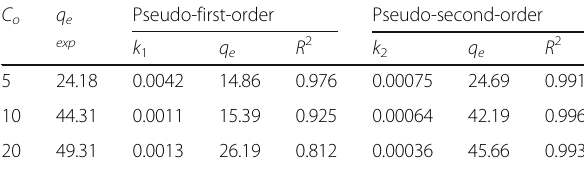
indicated the presence of GO in N6,6. The adsorption behavior of Cr (VI) onto N6,6/GO nanofibers was inves- tigated and the adsorption was found to be dependent on pH, adsorbent dosage, initial Cr (VI) concentration, and contact time. The maximum adsorption for Cr (VI) was at pH 2.0. The equilibrium between Cr (VI) and nanofibers was reached in 360 min. The equilibrium ad- sorption data were correlated by four adsorption iso- therm equations. Isotherm analysis demonstrated that the adsorption pattern of Cr (VI) onto nanocomposite followed the Langmuir model as well as Dubinin – Radushkevich (D – R) isotherm model. Using the Lang- muir model equation, the maximum capacity of N6,6/ GO was identified as 47.17 mg/g.